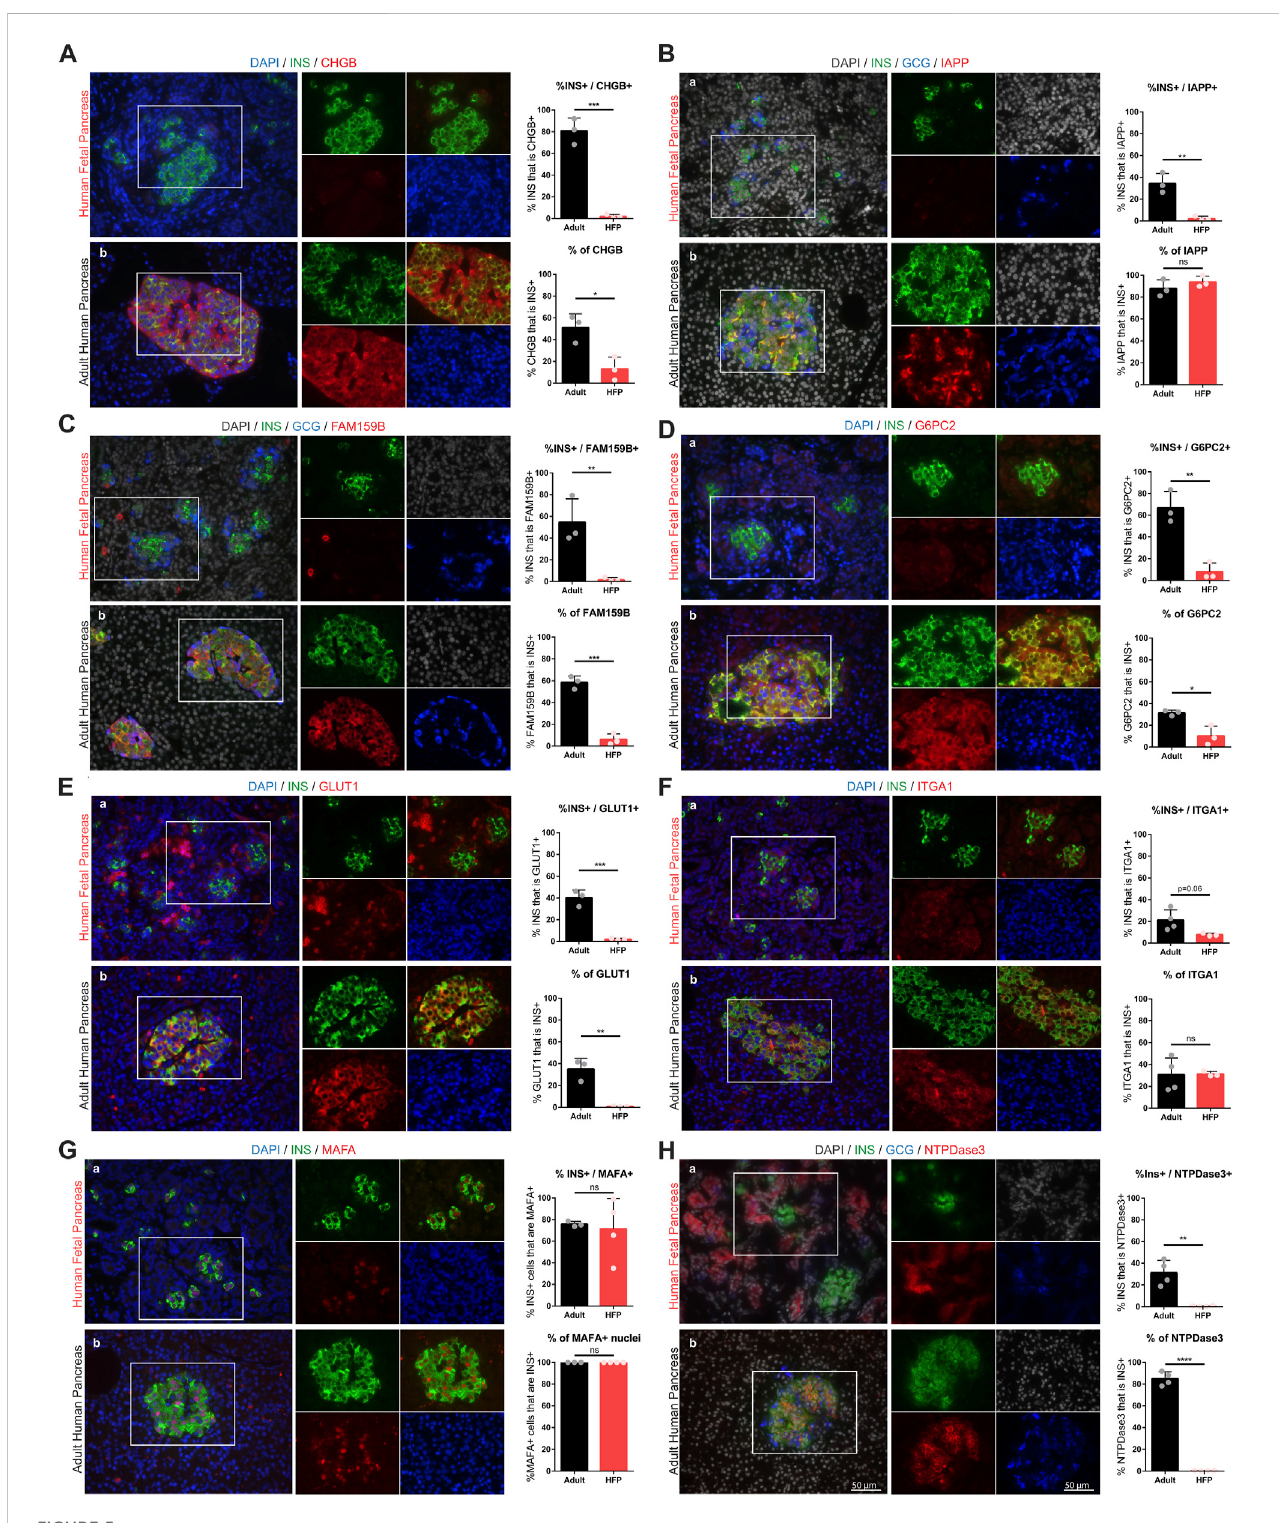
FIGURE 5 Protein expression and localization during human beta cell maturation. Immuno fl uorescent staining of candidate maturation markers reveals signi fi cant increaseinbetacell-speci fi cexpressionofCHGB (A) ,IAPP (B) ,FAM159B (C) ,G6PC2 (D) ,GLUT1 (E) ,ITGA1 (F) ,MAFA (G) ,NTPDase3 (H) inhumanfetalandadult pancreas sections. Individual channel images are the same magni fi cation as the larger merged images. Scale bars = 50 microns. For each marker, image quanti fi cation is depicted as the percentage of insulin that co-localizes with each marker (top graphs) and the percentage of each marker that co- localizes with insulin (bottom graphs). (ns = not signi fi cant, * p < 0.05, ** p < 0.01, *** p < 0.001, **** p <